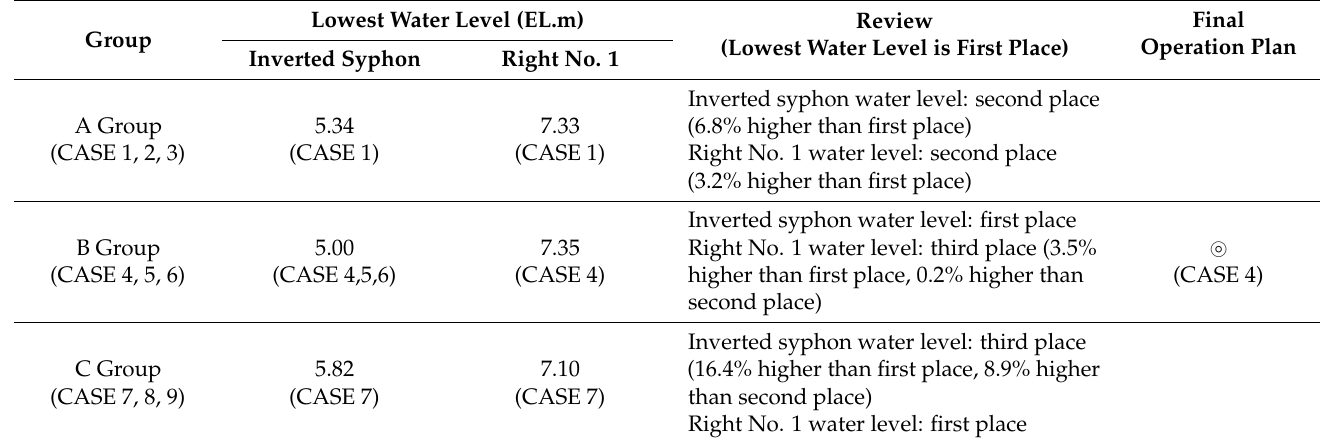
Table 7. Review of Water Level and Operation Plan Result.